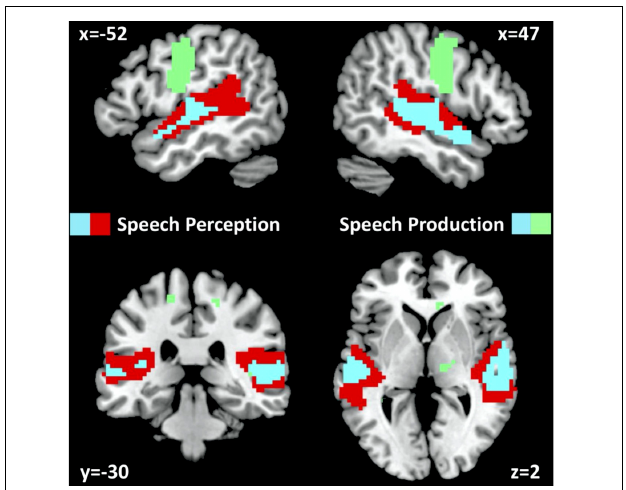
FIGURE 2 | fMRI activation for neurotypical control participants. fMRI activation clusters are shown for the 61 neurotypical control participants (NC) for the speech perception task (auditory semantic matching > visual semantic matching) and the speech production task (object naming > visual semantic matching). Cyan represents activated voxels for both auditory semantic matching and object naming. Red represents activated voxels for auditory semantic matching only and green represents activated voxels for object naming only. The statistical threshold was p < 0.05 with family wise error correction across the whole